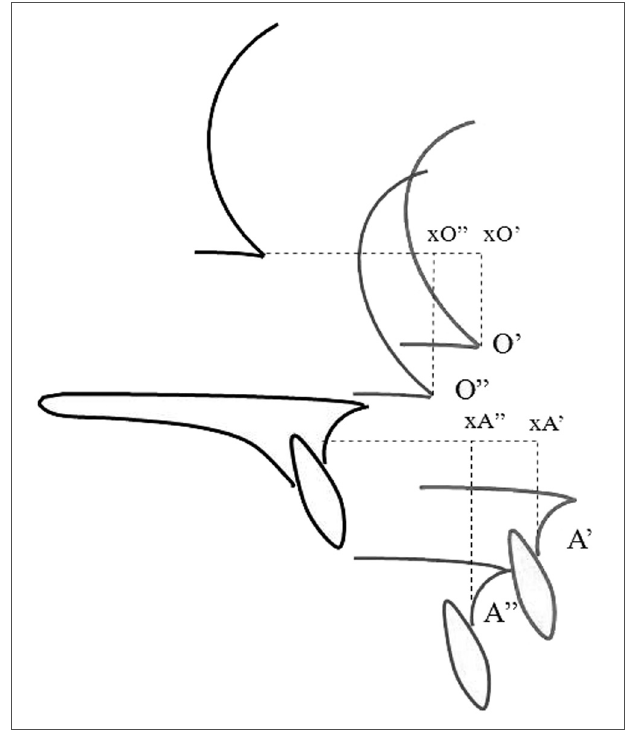
Figure 4. Representation of late horizontal repositioning measures: distances measured from reference points between early postoperative tracings (in red) and late postoperative tracings (in blue). A’: point A on the early postoperative tracing; xA’: projection of point A’ on the horizontal axis drawn from point A; A”: point A on the late postope- rative tracing; xA”: projection of point A” on the horizontal axis drawn from point A on the late postoperative tracing; O’: point O on the early postoperative tracing; xO’: projection of point O’ on the horizontal axis drawn from point O; O”: point O on the late postoperative tracing; xO”: projection of point O” on the horizontal axis drawn from point O on the late postoperative tracing. Distance xA’-xA”: amount of late posterior horizontal repositioning for point A. Distance xO’-xO”: amount of late posterior horizontal repositioning for point